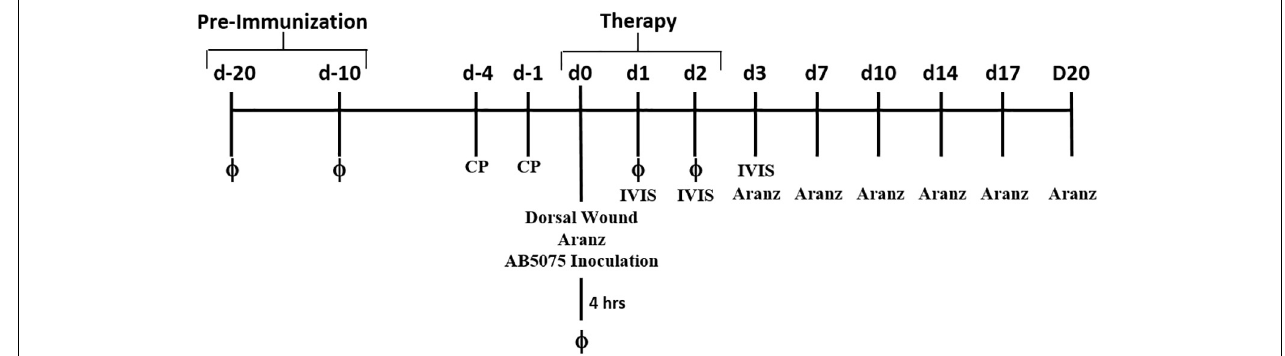
FIGURE 1 | Experimental timeline. Diagram of experimental treatments and model design.